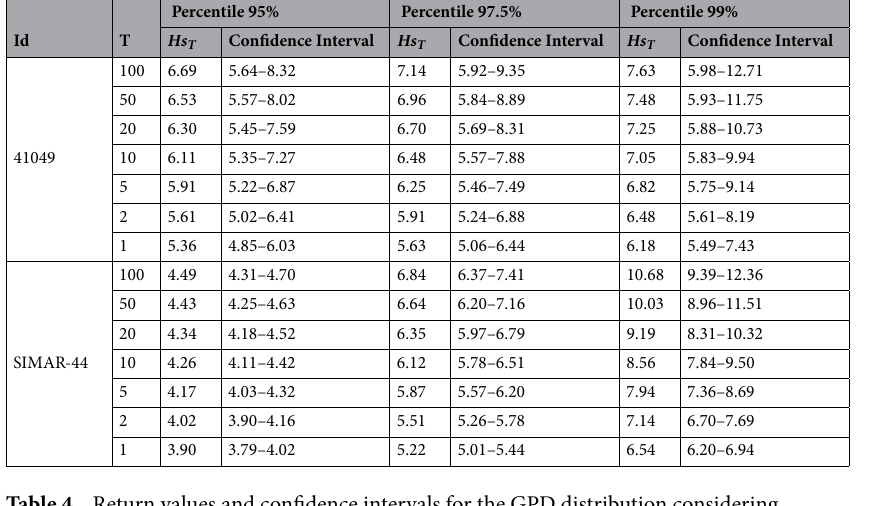
Table 4. Return values and confidence intervals for the GPD distribution considering T = ( 1, 2, 5, 10, 20, 50, 100 ) and the percentiles 95% , 97.5% , and 99%